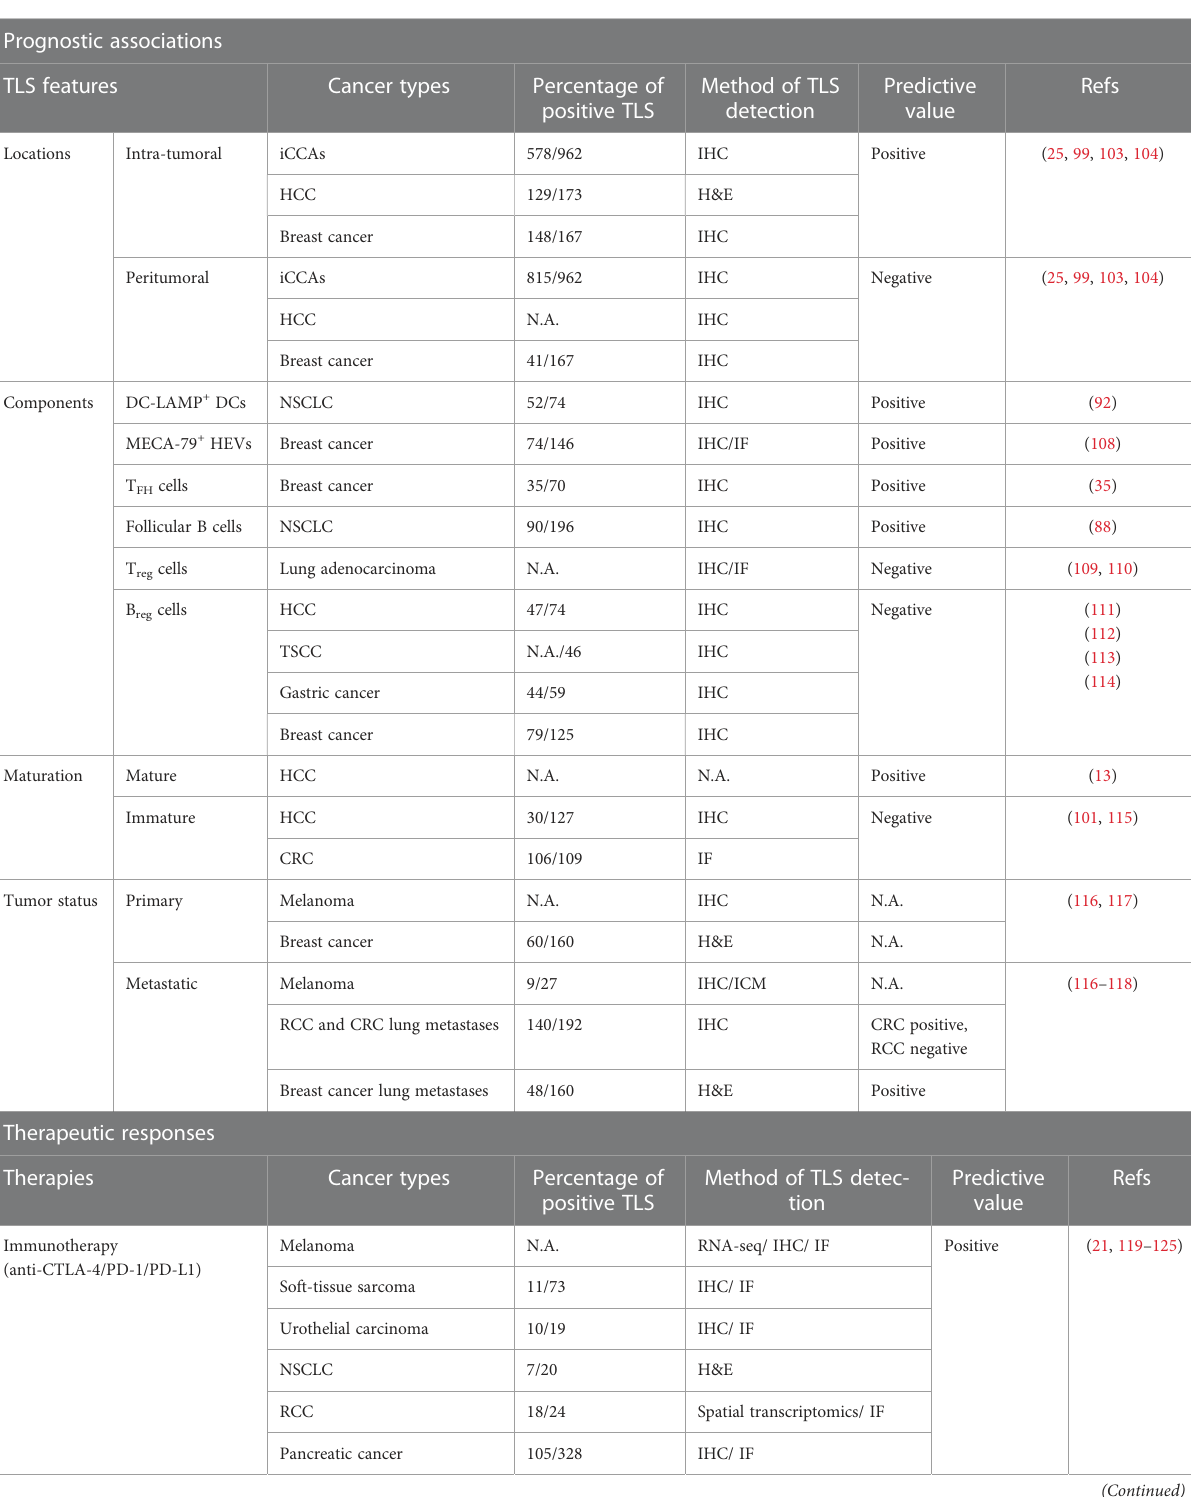
TABLE 2 TLSs as biomarkers in